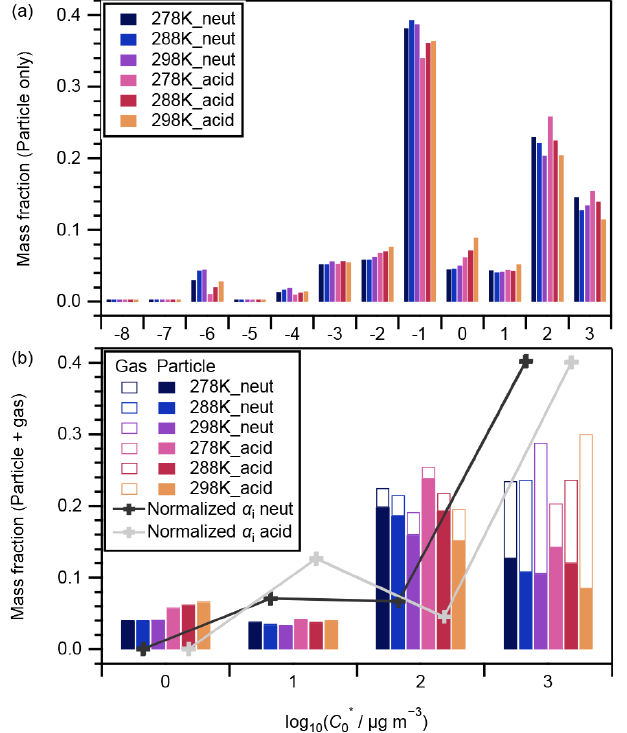
Figure 4. Volatility distributions of chemical components in (a) particle-only phase and (b) particle + gas phases. In panel (a) , data were normalized by the total signal intensity of the particle phase of each experiment; in panel (b) , data were normalized by the total intensity of the particle phase and its equilibrium gas phase in each experiment. Curves and markers imposed in panel (b) are the volatility distributions under neutral (black) and acidic (grey) seed conditions determined by normalizing the stoichiometric SOA yields α i by the total mass fraction of compounds in VBS bins 0 to 3 (Sato et al., 2018).